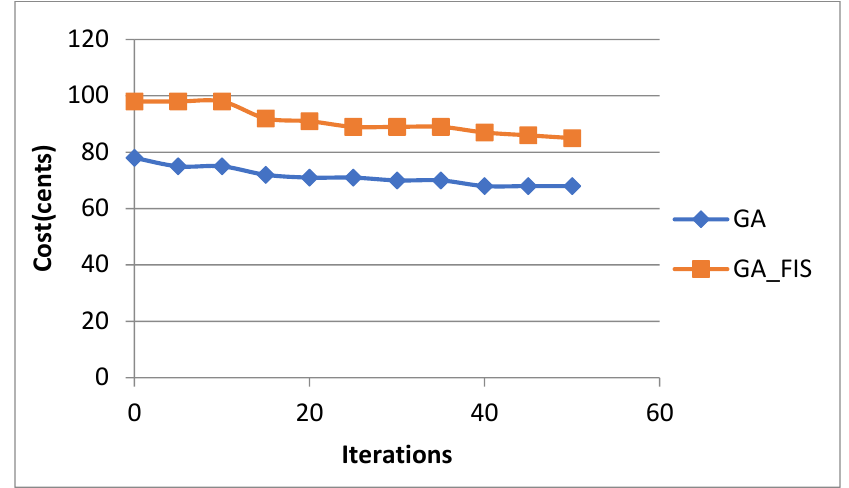
Figure 21. Fitness evolution graphs of GA_FIS and GA for smart load 1.